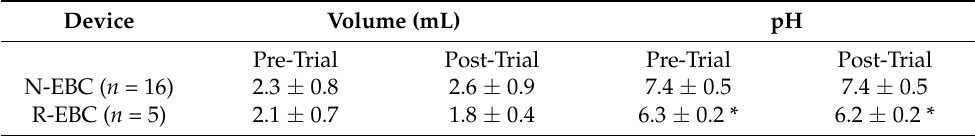
Table 2. Exhaled Breath Condensate (EBC) Collection